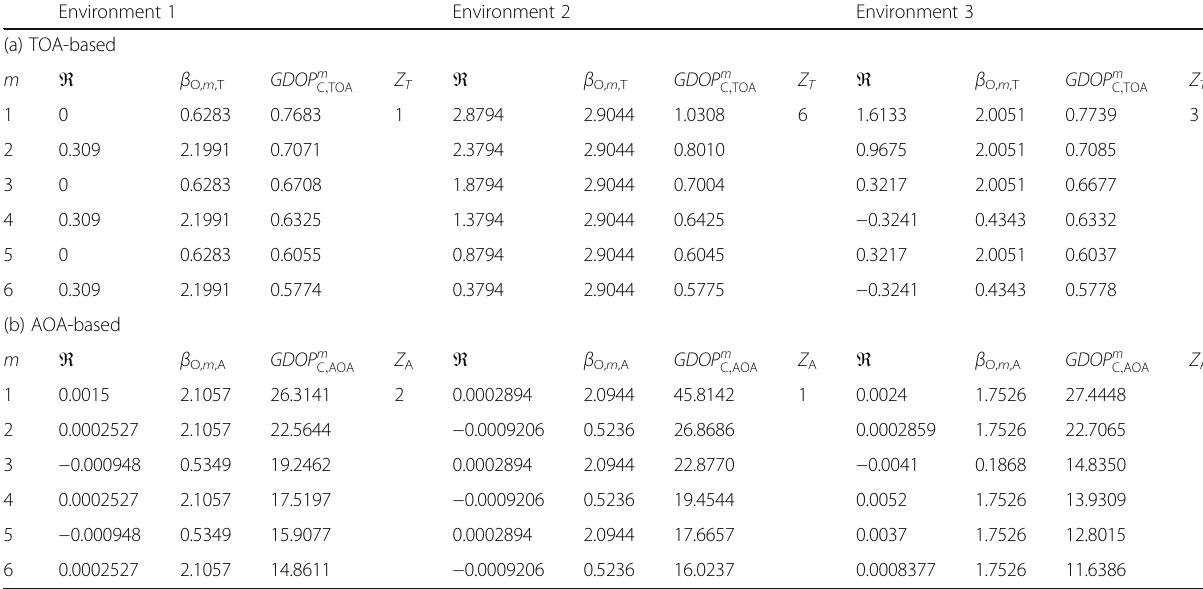
Table 2 Optimal performance obtained by OPMPD approach Environment